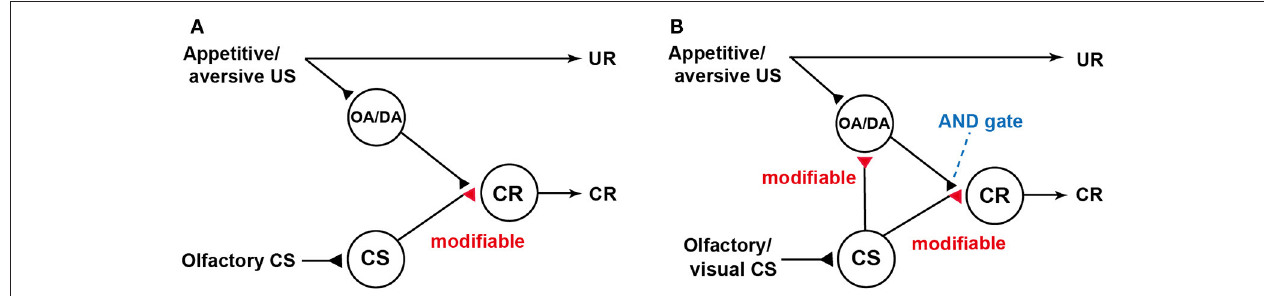
FIGURE 1 | Models of classical conditioning in flies and crickets. (A) A model proposed to account for the roles of intrinsic and extrinsic (output) neurons of the mushroom body (MB) in olfactory conditioning in fruit-flies (Schwaerzel et al., 2003). Octopamine neurons and dopamine neurons (“OA/DA” neurons) convey signals for appetitive and aversive US, respectively (In recent models in fruit-flies, “OA/DA” neurons have been replaced to different sets of DA neurons,). “CS” neurons, which convey signals for olfactory CS, make synaptic connections with “CR” neurons that induce a CR, which mimics an unconditioned response (UR). “OA/DA” neurons make synaptic connections with axon terminals of the “CS” neurons. The efficacy of the “CS-CR” synaptic connection is strengthened by coincident activation of “CS” neurons and “OA/DA” neurons by conditioning. For recent elaborations of the model in fruit-flies, see Hige (2017). (B) Our model of classical conditioning proposed for crickets (Mizunami et al., 2009). The model assumes that (1) efficacy of synaptic transmission from “CS” neurons to “OA/DA” neurons is strengthened by conditioning and that (2) coincident activation of “OA/DA” neurons and “CS” neurons is needed to activate “CR” neurons (AND gate) and to produce a CR. Synapses for which the efficacies are modifiable by CS-US pairings are shown as open triangles and marked “modifiable”. Following the terminology of learning theories in mammals, the model in flies is characterized as an S-R model assuming formation of CS-CR connections, while our model is characterized as an S-R and S-S hybrid model assuming formation of CS-CR and CS-US connections. Modified from Mizunami et al. (2009).